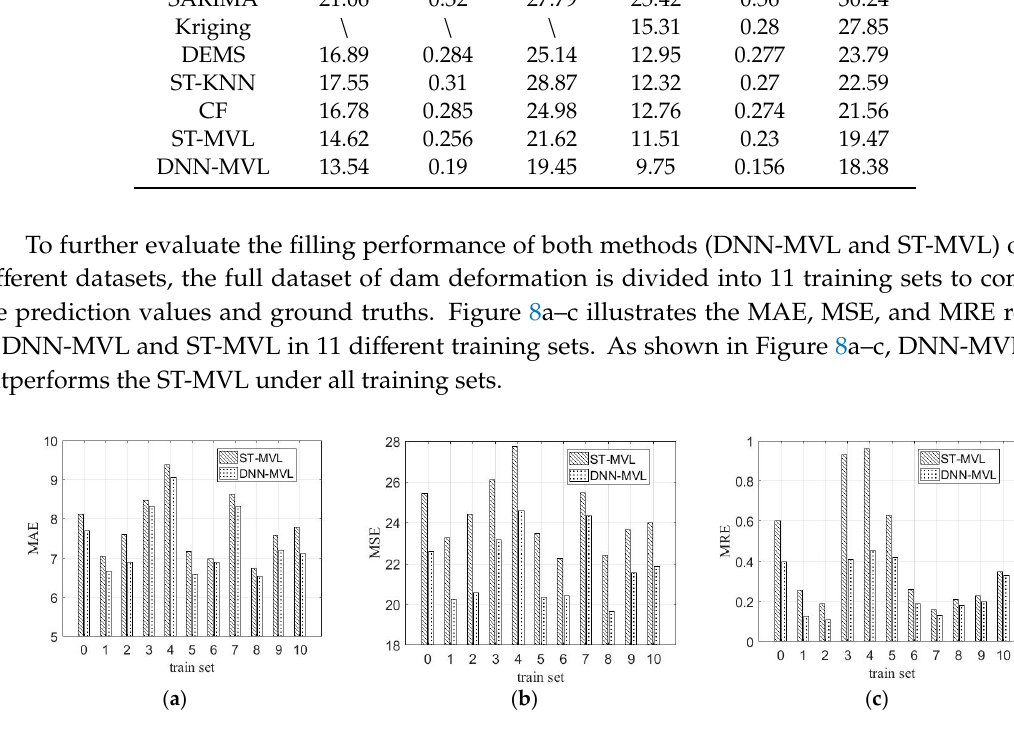
Figure 8. Comparisons in evaluations of training set. ( a ) Mean absolute error (MAE); ( b ) mean square error (MSE); ( c ) mean relative error (MRE).